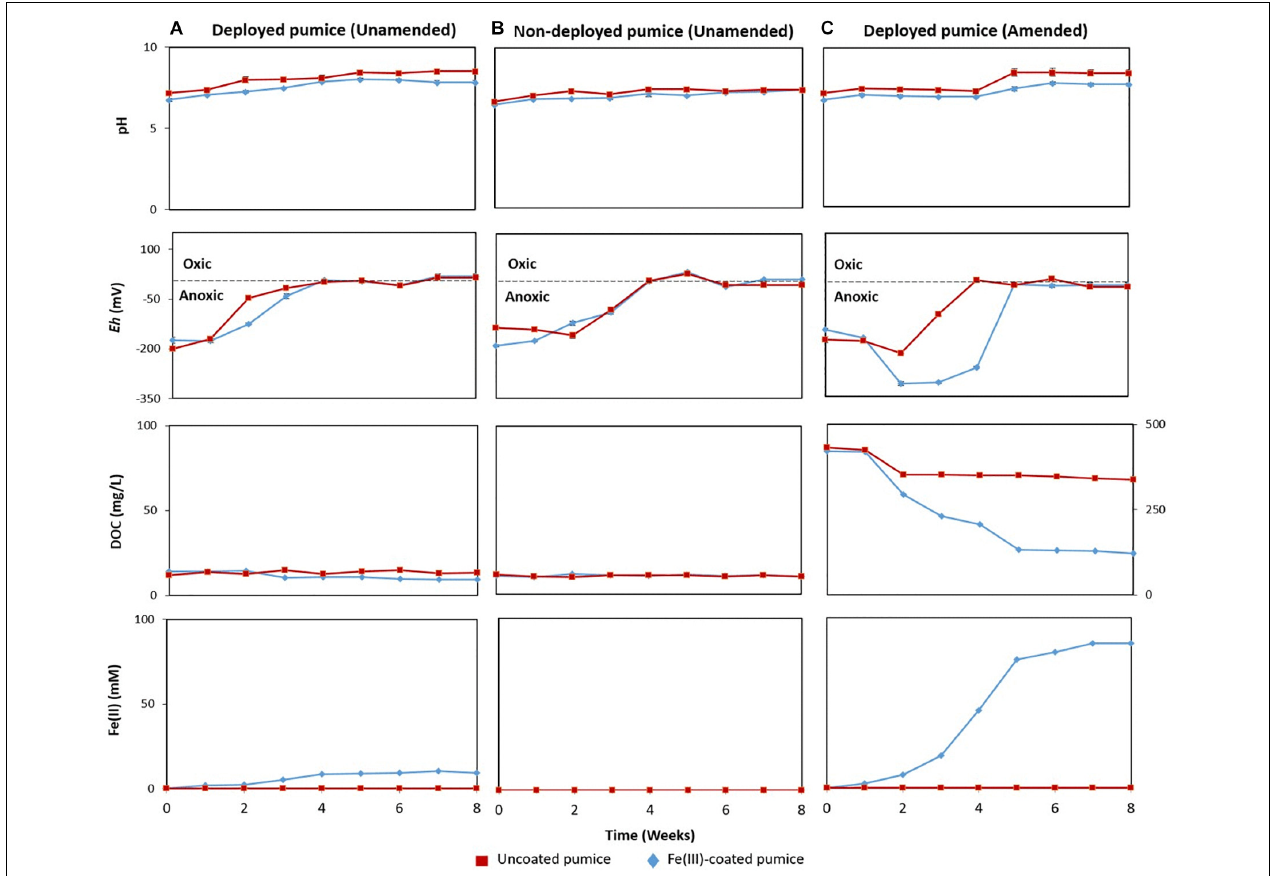
FIGURE 3 | Measurements of pH, redox potential ( Eh ), dissolved organic carbon (DOC) and Fe(II) concentrations, in anaerobic microcosms of pumice slurries incubated at 20 ◦ C for 8 weeks and set up in the following batches: (A) Deployed pumice unamended with electron donors, (B) Non-deployed pumice unamended with electron donors. (C) Deployed pumice amended with lactate and acetate. Data are means ± standard errors of